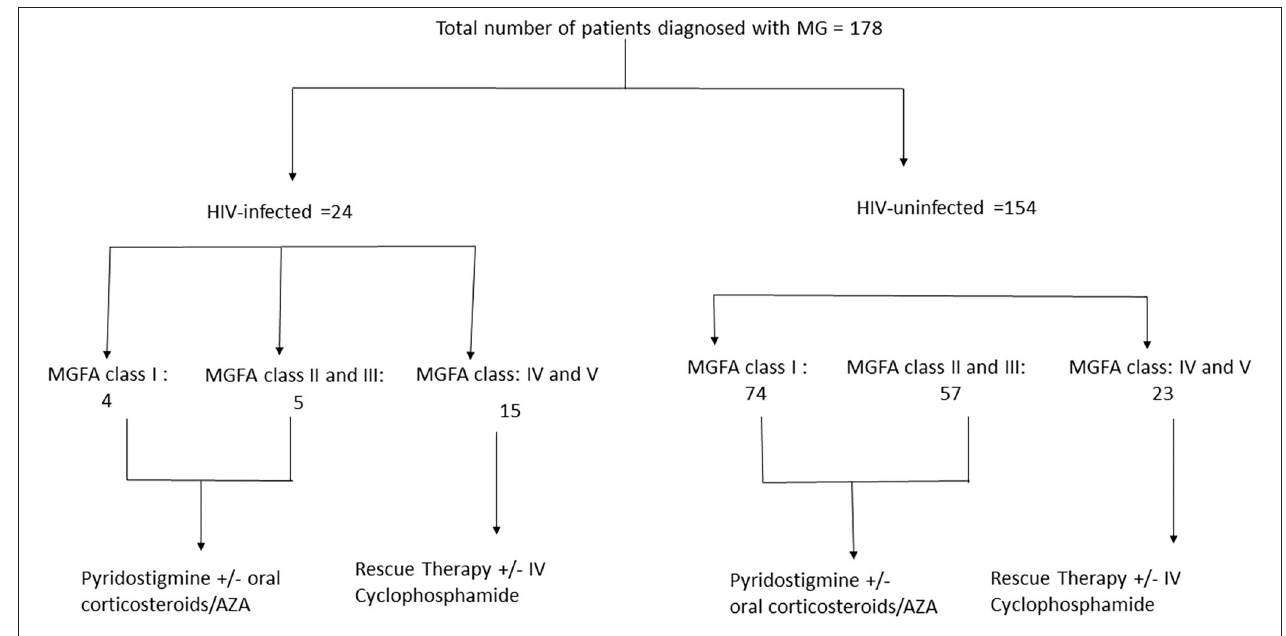
FIGURE 1 | Consort